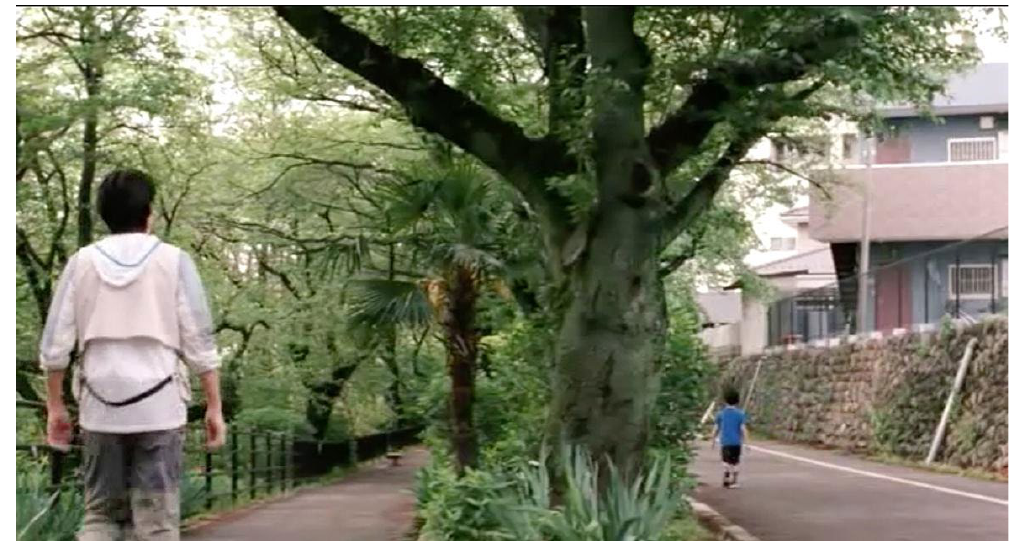
Figure 20 Architect Ryota finally draws the line of his thought on their